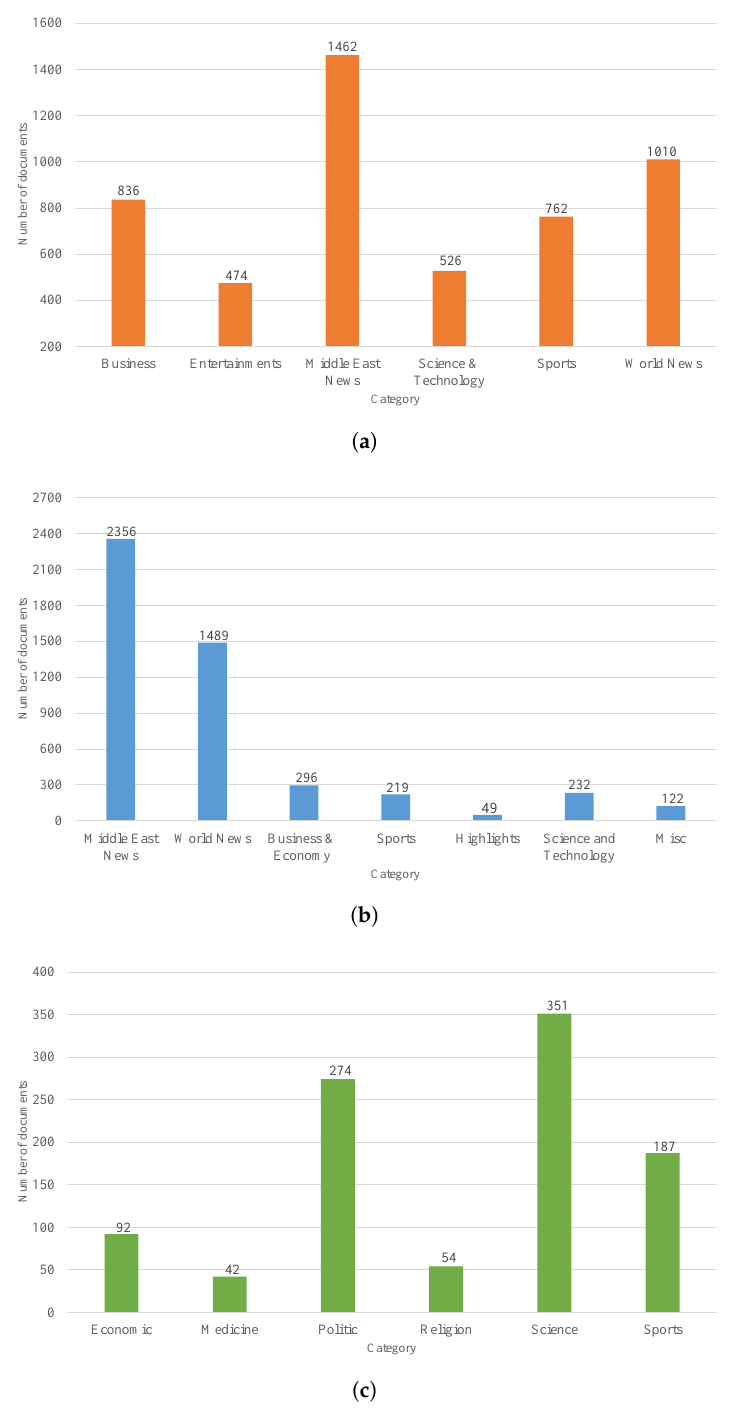
Figure 2. Document distribution for: ( a ) DatasetB; ( b ) DatasetC; ( c ) DatasetE.